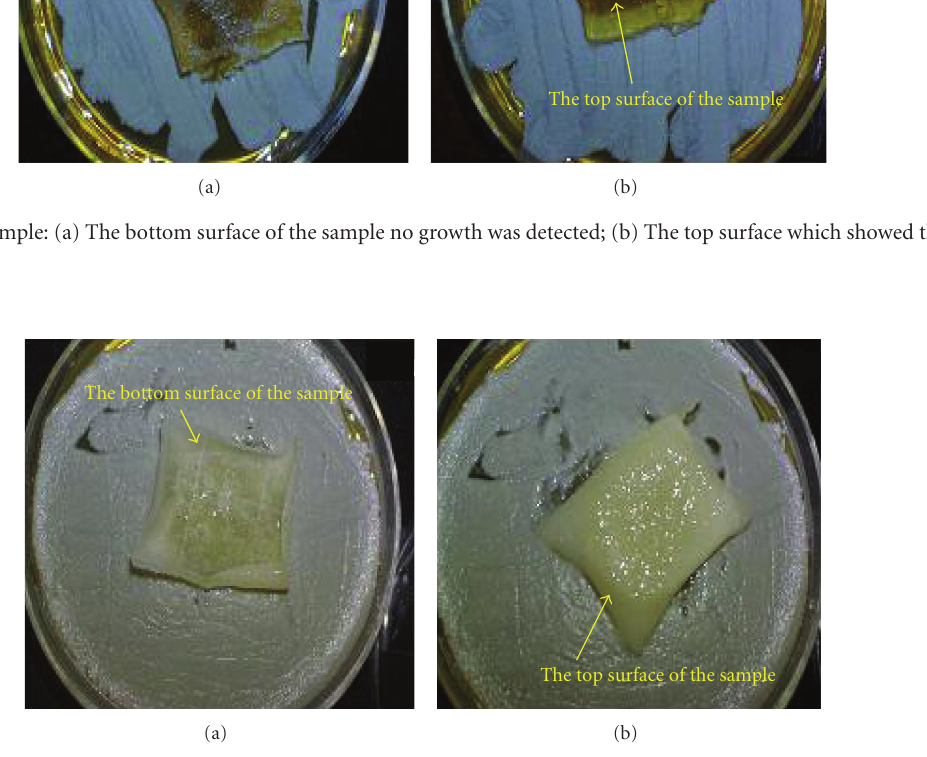
Figure 2: Transparent Comfeel sample: (a) The bottom surface which showed the growth of fungi; (b) The top surface where fungi has completely grown on